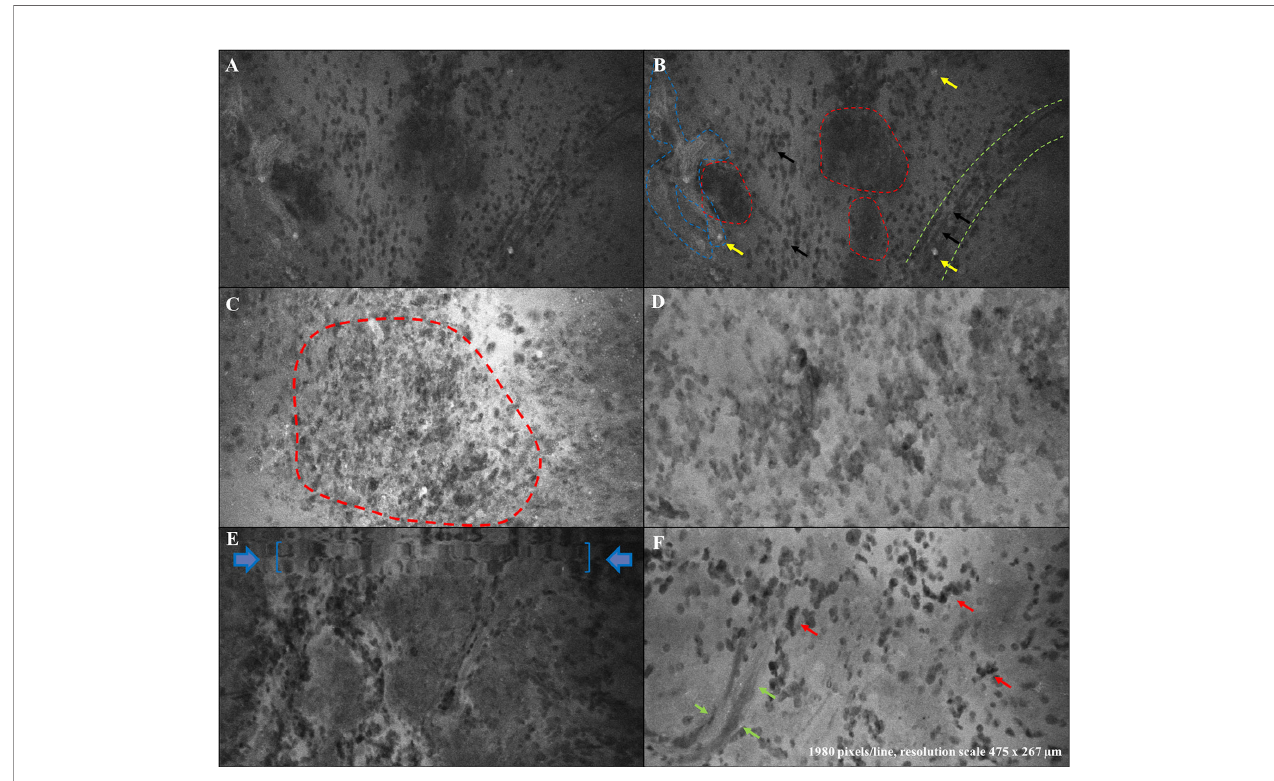
FIGURE 1 | Ex vivo confocal hallmarks of GBM. (A, B) report the same image of a GBM tumor tissue sample as seen through CONVIVO ® system. High- density tumor areas are identi fi able as agglomerates of cells appearing darker than the background (red-dotted lines, B ). As expected, some cells absorbed SF (yellow arrows, B ). Green-dotted lines in (B) delineate the contour of a neo-angiogenetic vessel with erythrocytes inside and outside it (smaller than tumor cells, black arrows). Blue-dotted lines demonstrate SF diffused out of vessels (BBB disruption), creating a fuzzy appearance. (C) Another GBM case: high density tumor tissue (red dotted line) appeared brighter due to a closer time between SF injection and sample analysis. (D) Another GBM case characterized by high cellularity, pleomorphism with large dysmorphic nuclei and agglomerates of cells. (E) A movement artifact on a GBM CLE image (blue arrows and commas). (F) Another GBM case with pleomorphic cells (dark nuclei, apparently tumor cells, red arrows) visible on a brighter SF background. Green arrows contour a neoangiogenetic